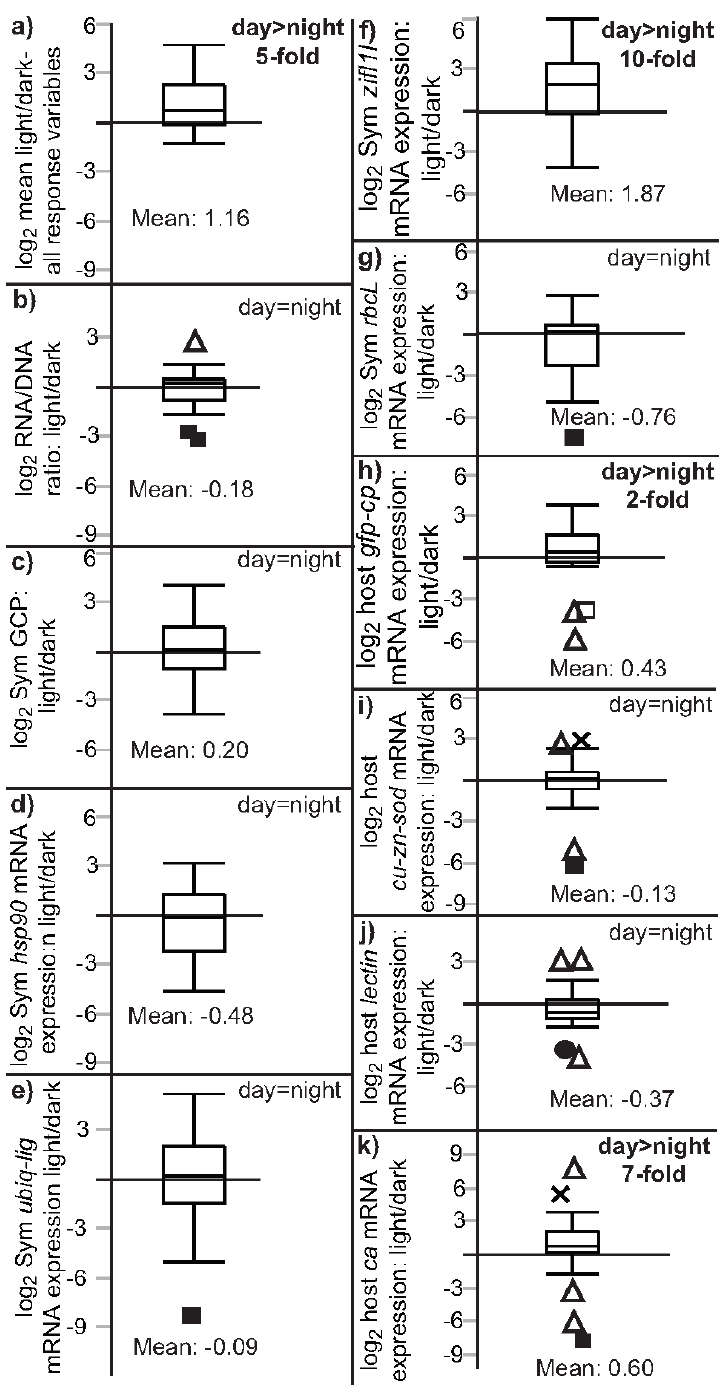
Figure 4. Mean light/dark ratios for the 26 coral colonies sampled at both midday and night. Ratio data were log 2 -transformed, and signed-rank (non-parametric) tests were used to determine whether the transformed values of the geometric mean ( a ) plus the 10 response variables ( b – k ) were significantly higher than 0 (equivalent to whether the untransformed ratios were significantly higher than 1); only the geometric mean ( a ), Symbiodiniaceae (Sym) zifl1l ( f ) mRNA expression, and host coral gfp-cp ( h ) and ca ( k ) mRNA expression fulfilled this criterion ( p < 0.02 for all). The null hypothesis value of 0 is plotted as a solid horizontal line in each panel. The icon legend follows Figure 2.